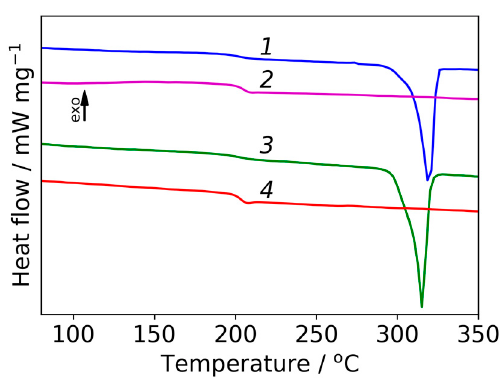
Figure 8. DSC curves of initial polyimide film: first scan ( 1 ), second scan ( 2 ) and of composite film with ZrO 2 nanostars: first scan ( 3 ), second scan ( 4 ).